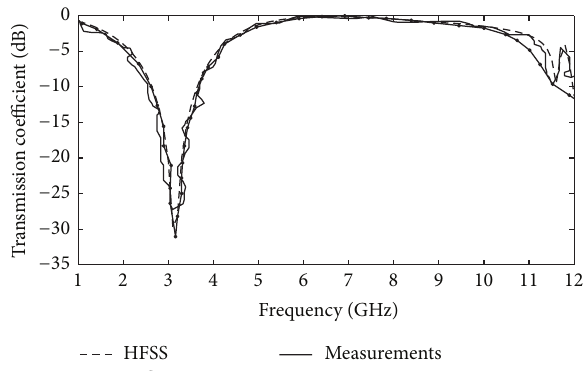
Figure 6: Simulated and measured results of the transmission coefficient for the FSS with cross fractal patch elements (FSS 1 ).